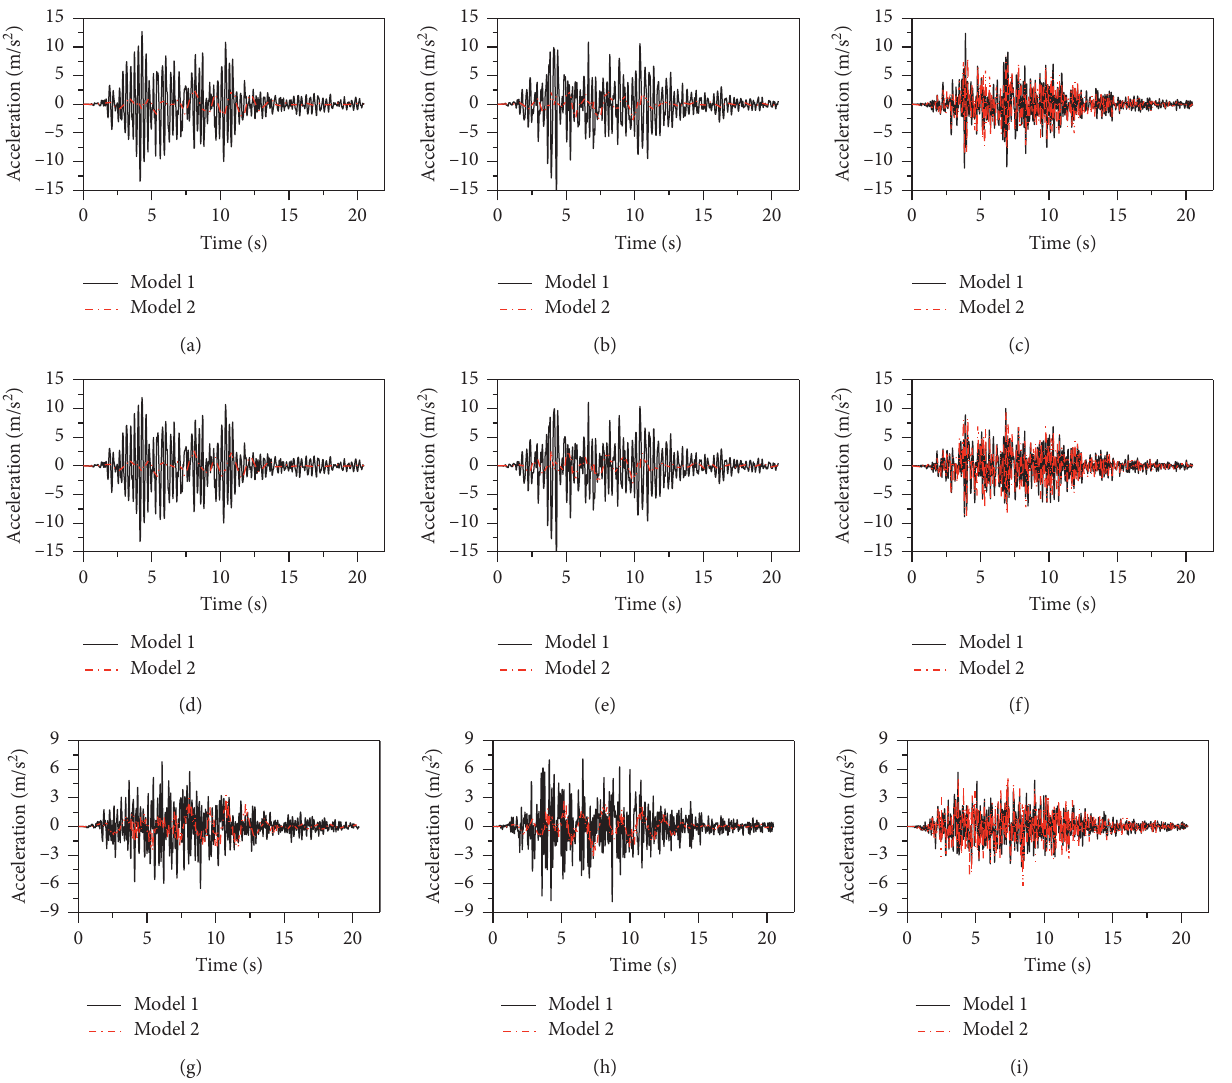
Figure 8: Comparisons of acceleration responses under artificial ground motion: (a) P1- X -direction, (b) P1- Y -direction, (c) P1- Z -direction, (d) P7- X -direction, (e) P7- Y -direction, (f) P7- Z -direction, (g) P10- X -direction, (h) P10- Y -direction, and (i) P10- Z